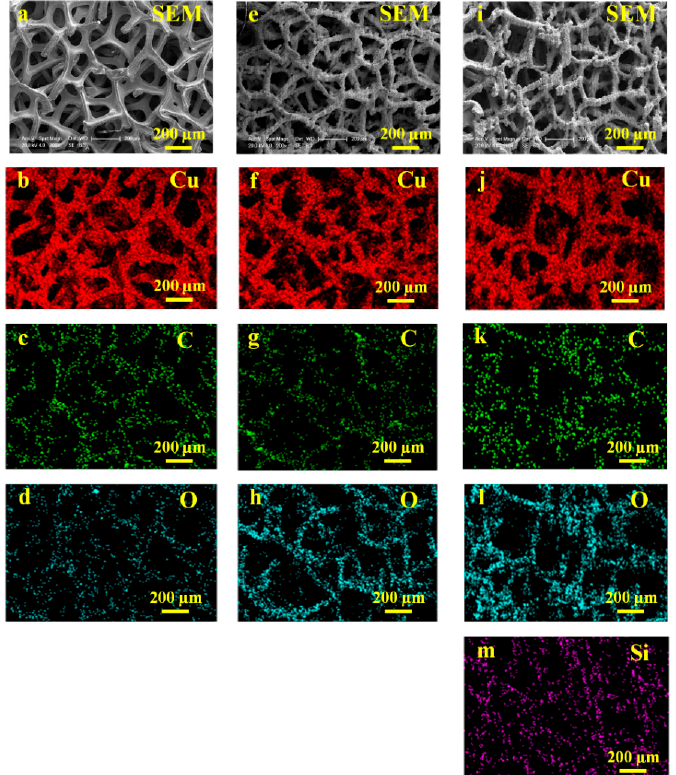
Figure 10. SEM/EDS elemental mapping for ( a – d ) untreated Cu foam; ( e – h ) laser-textured Cu foam;